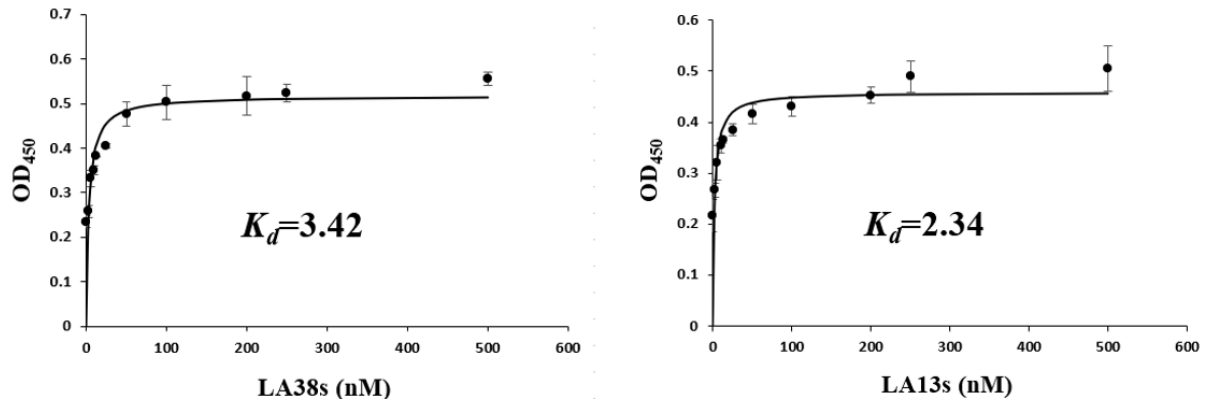
Figure 2. Affinity analysis of truncated aptamers against LMBV. LMBV was incubated with differ- ent concentrations (0–500 nM) of 5 ′ -biotinylated aptamers. The specific K d was calculated using standardized nonlinear regression analysis by SigmaPlot software. Results were presented as the mean ± SD.